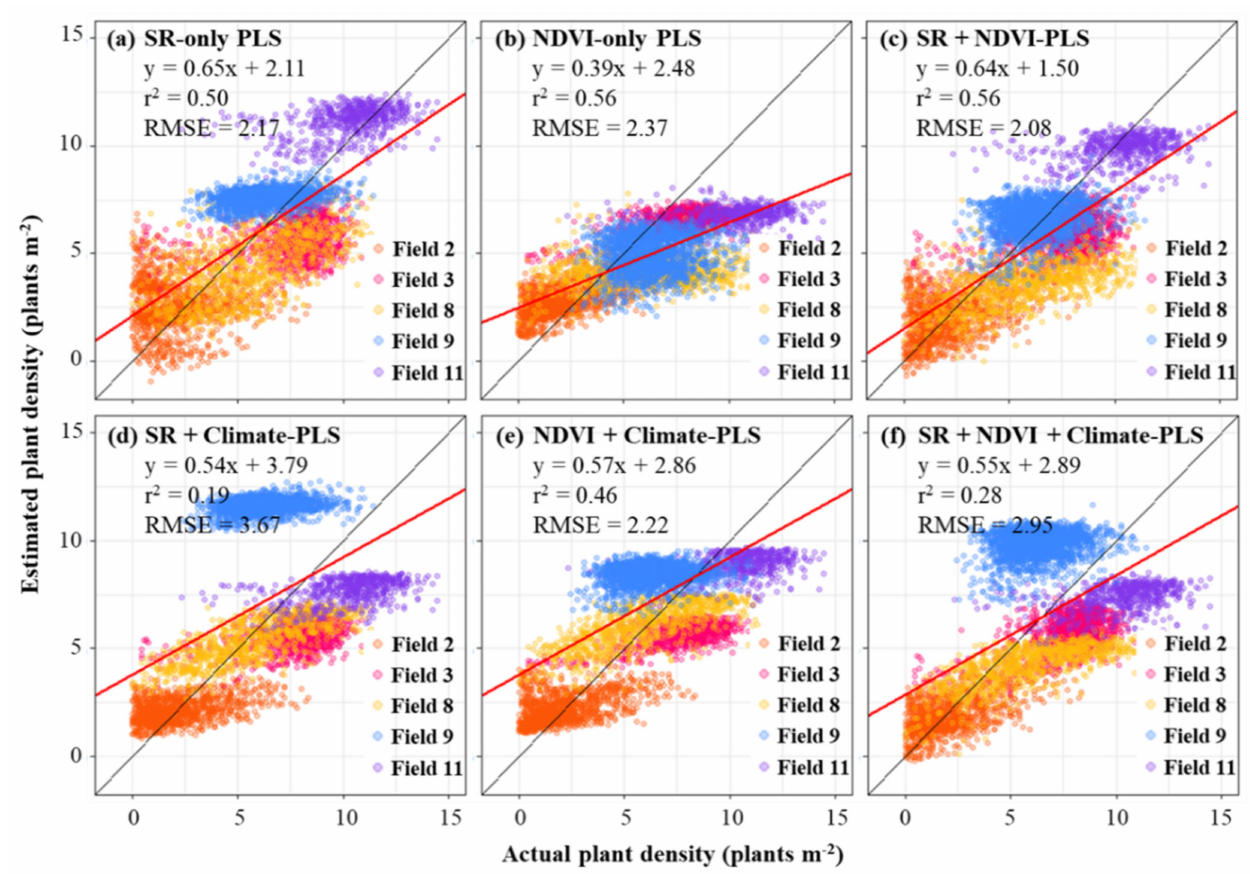
Figure 6. Relationships between actual plant density derived from the YOLOv3 model and estimated plant density (plants m − 2 ) derived from ( a ) SR-only PLS; ( b ) NDVI-only PLS; ( c ) SR + NDVI-PLS; ( d ) SR + Climate-PLS; ( e ) NDVI + Climate-PLS; ( f ) SR + NDVI + Climate-PLS of test data set. The red line represents a regression line. The black line represents a 1:1 relationship. Different color points represent the field